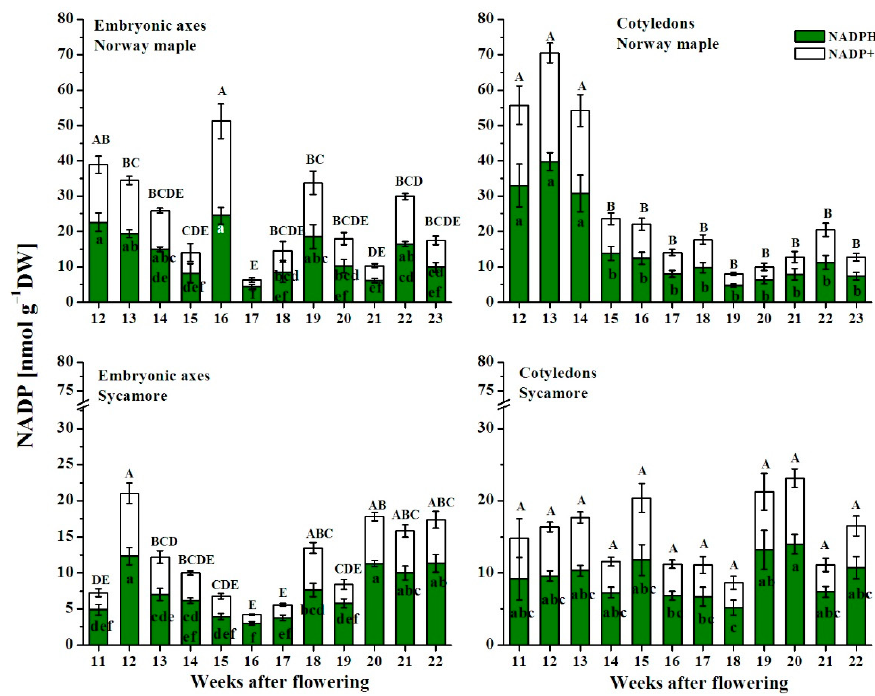
Figure 8. Changes in the levels of the reduced (NADPH) and oxidized (NADP + ) forms of nicotinamide adenine dinucleotide phosphate (NADP) in the embryonic axes and cotyledons of the developing seeds of Norway maple and sycamore collected during the 11th–23rd weeks after flowering. Data are the means of three independent replicates ± the standard error. Statistically significant differences are indicated with different letters (one-way ANOVA, followed by Tukey’s test at p < 0.05). The capital letters refer to NADP + .